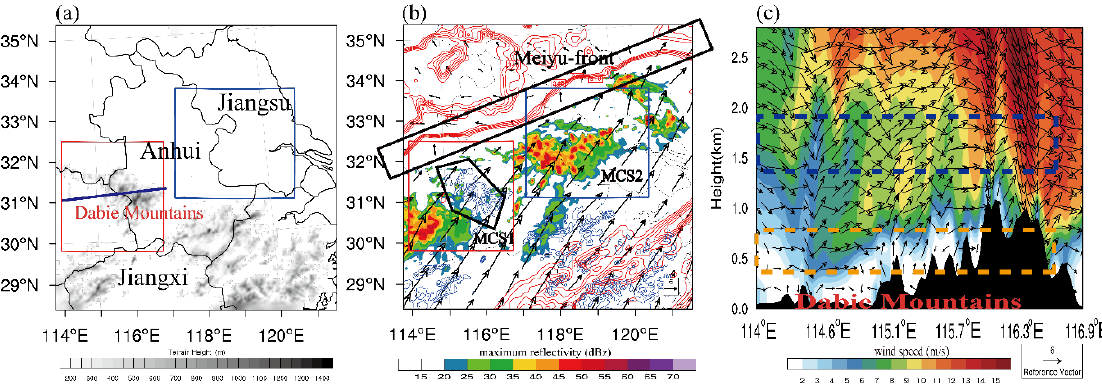
Figure 1. ( a ) Analysis domain. The color shading represents the terrain height (m). The red and blue rectangles correspond to the MCS1 and MCS2 regions, respectively. ( b ) Maximum reflectivity (dBz, color), 850 hPa wind vectors (m / s) and 850 hPa equivalent potential temperature (K, black contours from 344 to 348) and terrain height (m, blue contours) at 14:00 UTC 6 July 2013 of TRUE. ( c ) Vertical speed (shaded, m / s) and wind vectors at 14:00 UTC from TRUE in a vertical cross-section along the blue line in Figure 1a. The blue square marks the general range of synoptic low-level jet while the orange square marks the range of boundary layer low-level